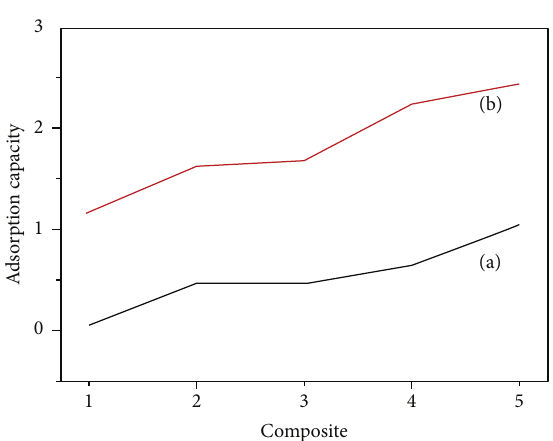
Figure 6: Adsorption capacity of bacterial cellulose and eggshell composite membrane. (a) Water adsorption. (b) Vegetable oil adsorption. (1) Neat bacterial cellulose. (2) 1: 0.5 weight ratio of bacterial cellulose and eggshell. (3) 1:1 weight ratio of bacterial cellulose and eggshell. (4) 1: 2 weight ratio of bacterial cellulose and eggshell. (5) 1: 5 weight ratio of bacterial cellulose and